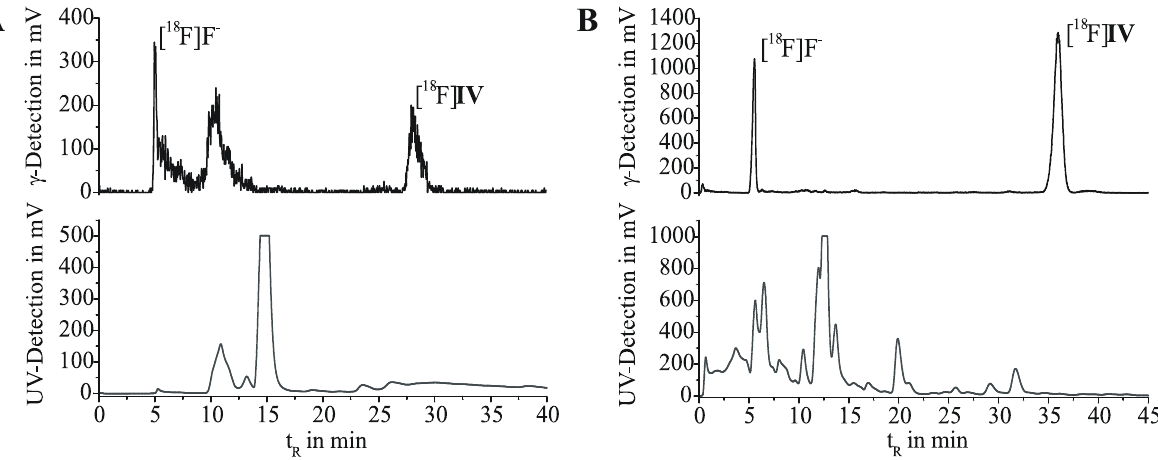
Figure 2. Semi-preparative HPLC chromatograms for purification of [ 18 F] IV . ( A ) After two-step radiosynthesis. Multospher 120 RP-18 AQ column; 55% MeCN/H NH OAc; flow rate 2 mL/min. ( B ) After one-step radiosynthesis. Reprosil-Pur 4